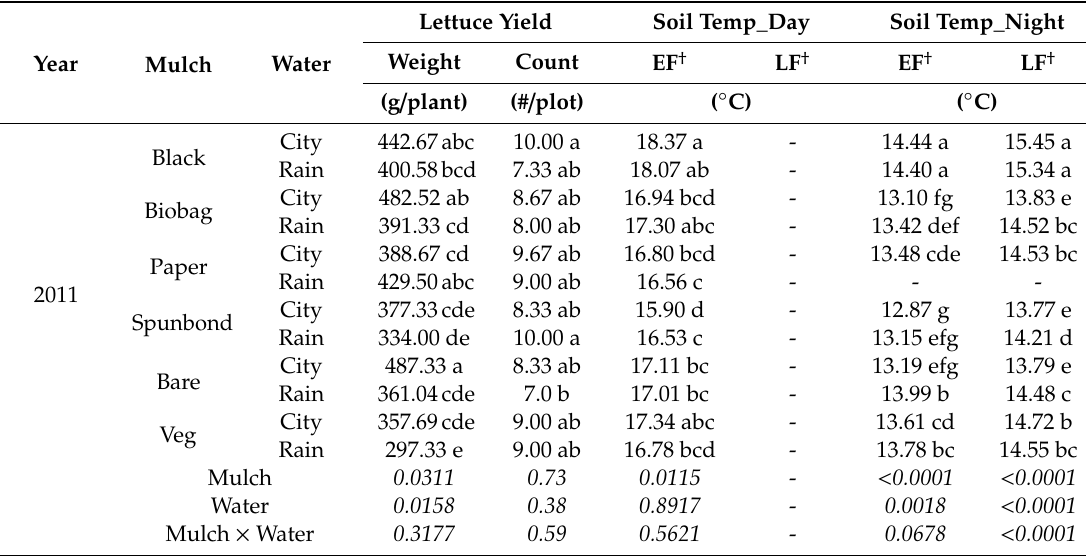
Figure 6. Fluctuations in average water temperature (mean ± SE) for three fall seasons of years 2011, 2013, and 2014. Gravity and Solar represent the rainwater inside the gravity and solar tanks, respectively, and City represents the municipal water from the underground pipes. Table 3. Interactions of mulch and water on the lettuce yield and soil temperature inside high tunnels during all three falls of years 2011, 2013, and